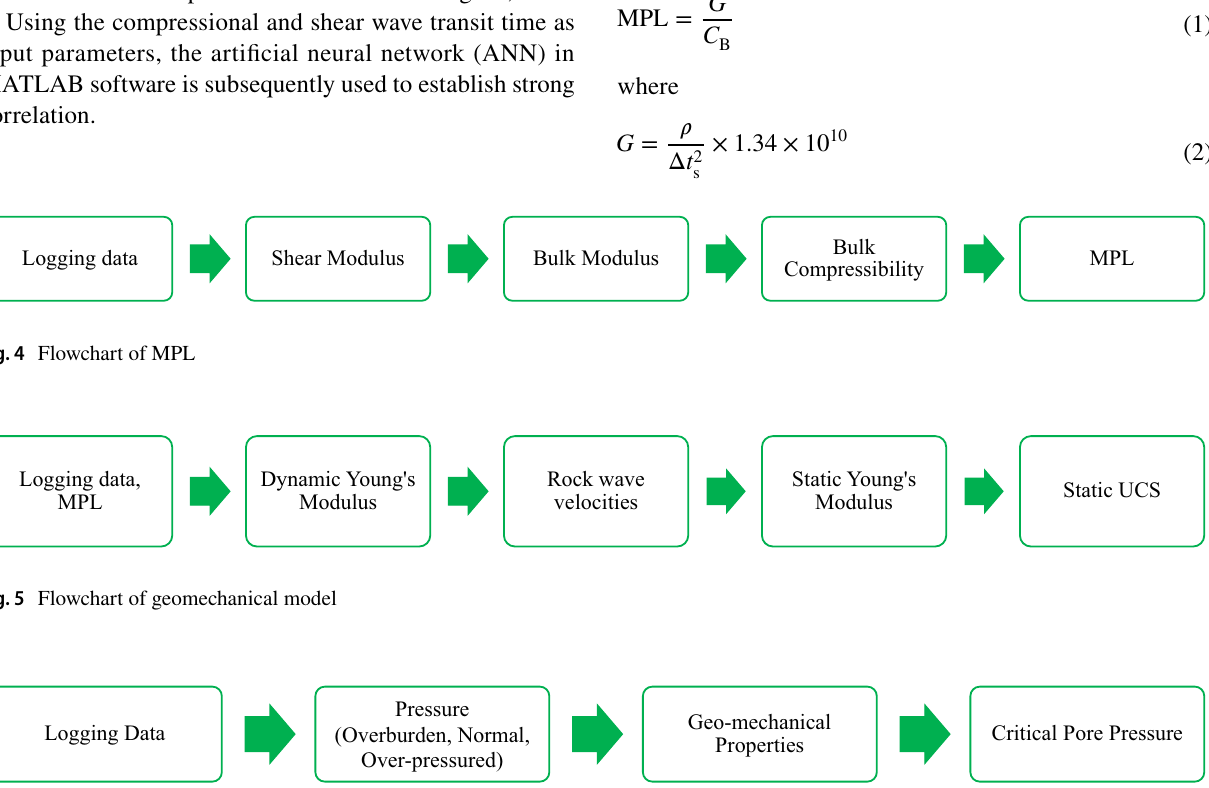
Fig. 6 Flowchart for calculating the critical pore pressure [Mohr-Coulomb’s